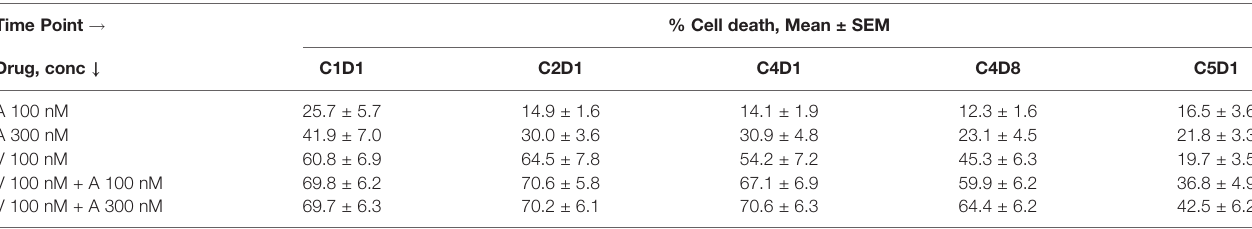
TABLE 2 | Percent cell death in PBMCs obtained during ibrutinib and venetoclax trial after ex vivo incubations with AMG-176 alone, venetoclax alone, or both drugs in